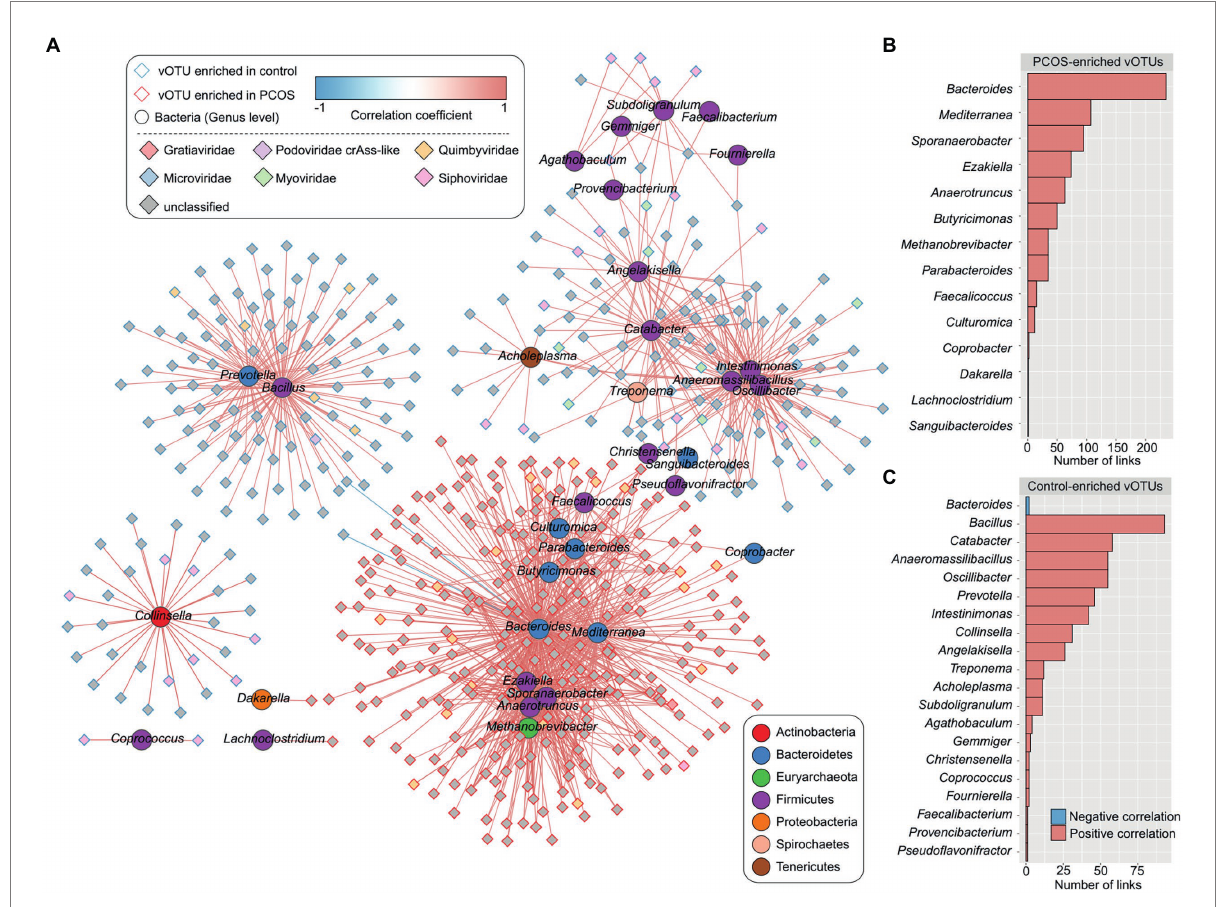
FIGURE 5 Correlation analysis between PCOS-associated vOTUs and gut bacteria (genus level). (A) Network showing the correlations of the vOTUs and bacterial genera. The Spearman’s correlation coefficient was used to evaluate the correlation, and correlations with an absolute correlation coefficient > 0.60 and Spearman’s correlation test q < 0.05 are shown in the network. Blue and red lines represent negative and positive correlations, respectively. (B,C) Bar charts showing the number of links between bacterial genera and PCOS-enriched vOTUs (B) and between bacterial genera and control-enriched vOTUs (C)